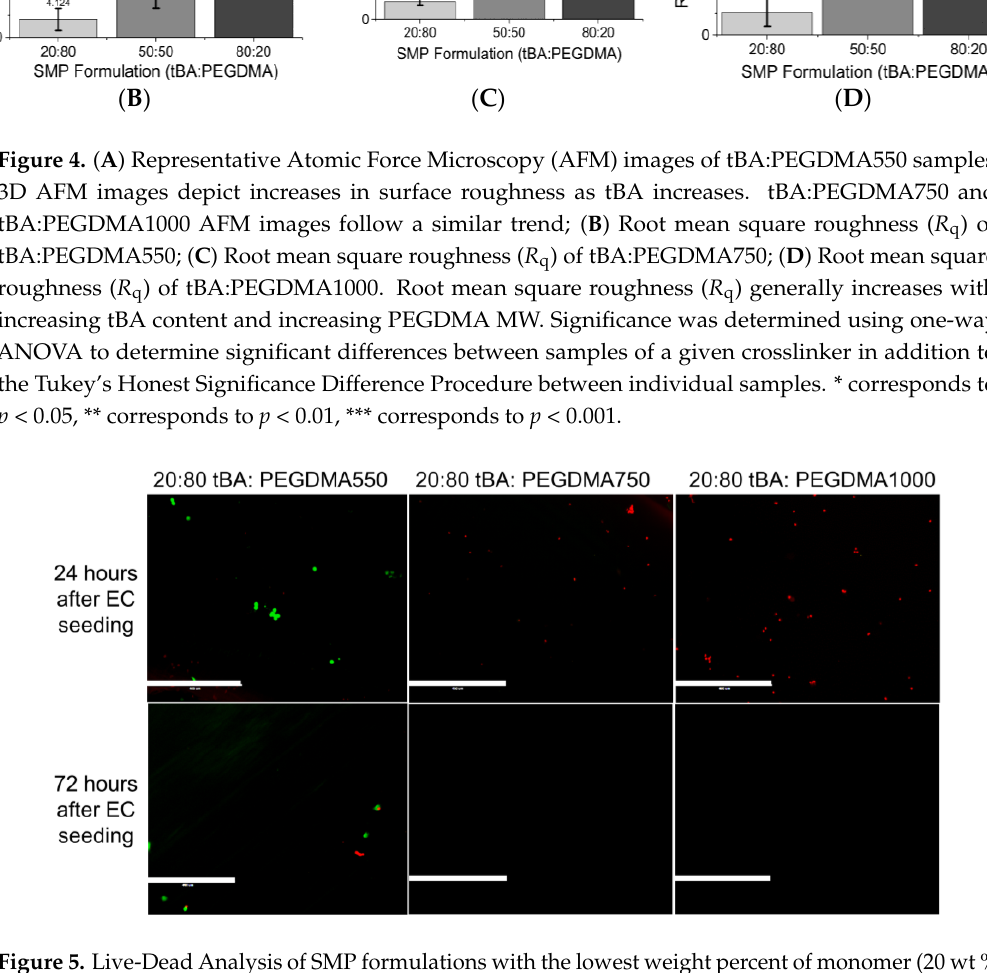
Figure 5. Live-Dead Analysis of SMP formulations with the lowest weight percent of monomer (20 wt % tBA). These samples show little to no endothelial cell attachment and have a high presence of dead endothelial cells. Scale bar = 400 µm.